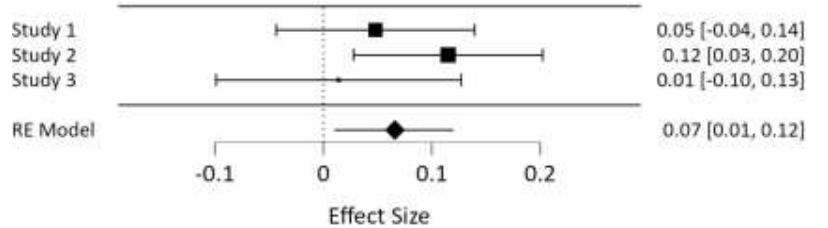
Figure 18. Forest plot of meta-analysis of Motivation for stimulation and Extraversion